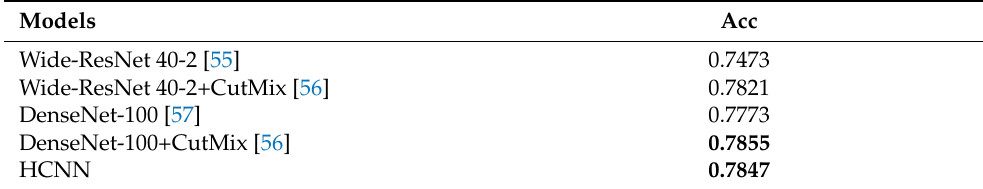
Figure 7. The curve graph of Table 6. Table 7. The experimental results of Adaboost-CNN and HCNN on the CIFAR-100